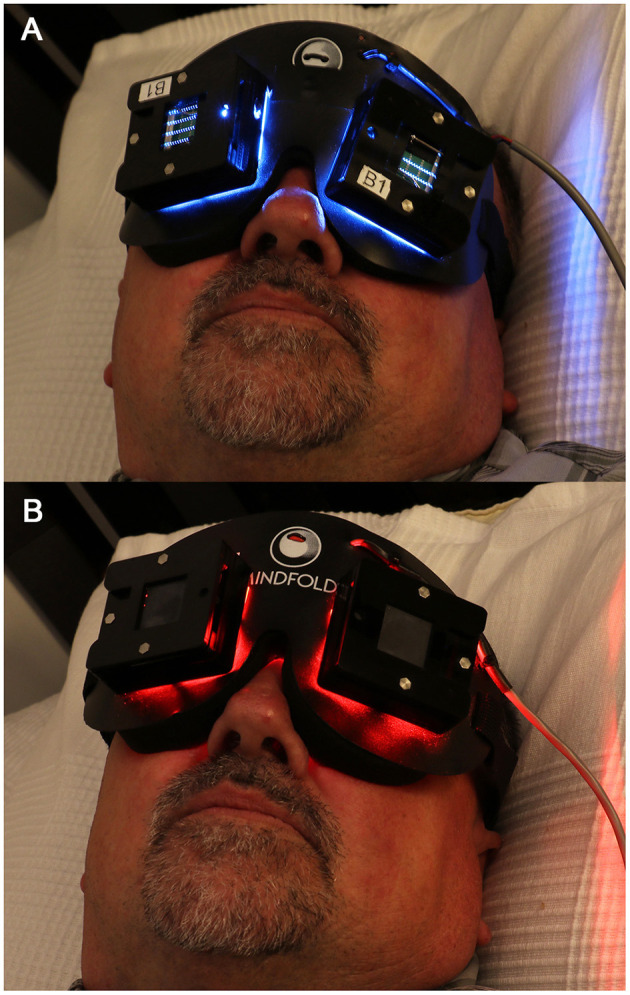
The light mask used to deliver light pulses through closed eyelids during sleep. The light mask contained 2 LED arrays for each eyelid: (A) active blue (λmax = 480 nm, FWHM = 24 nm) or (B) placebo red (λmax = 640 nm, FWHM = 25 nm). Written informed consent was obtained from the individual shown in this figure for the publication of this image.